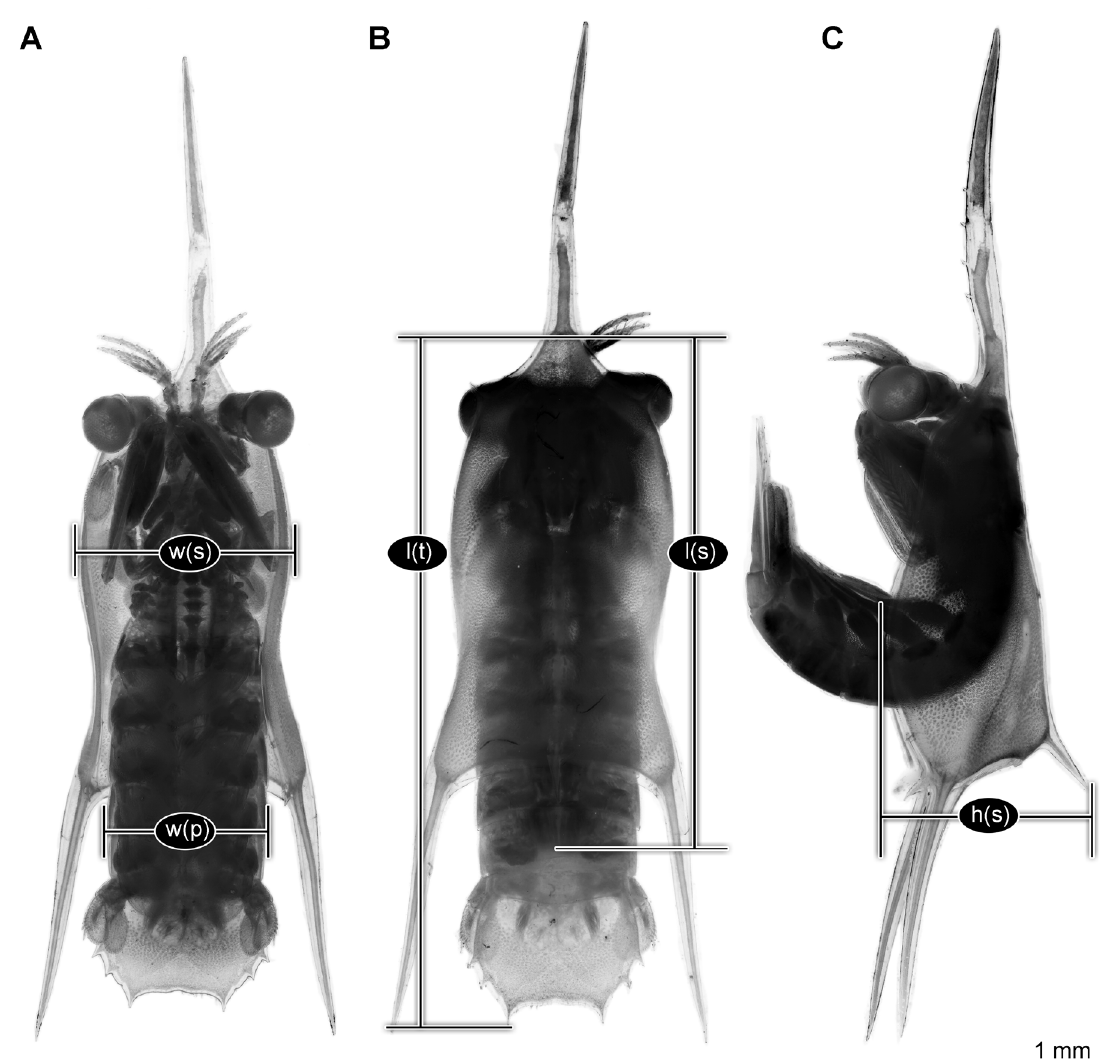
Figure 1. Measurements exemplified on specimen NHMD-232175. A. Ventral view. B. dorsal view. C. Lateral view. Abbreviations: h(s) = height of shield (including spines); l(s) = length of shield (from insertion area of rostrum to posterior end of midline, hence excluding postero-lateral spines); l(t) = total length (from insertion area of rostrum to posterior end of telson including telson spines); w(p) = maximum width pleon; w(s) = maximum width shield (excluding